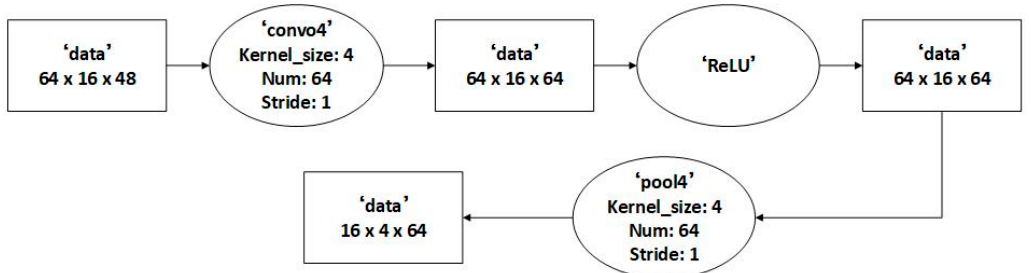
Figure 8. Convo4 convolutional layer process.